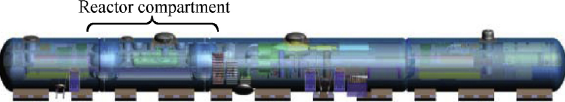
Fig. 2. Pro fi le view of a Flexblue ® module.